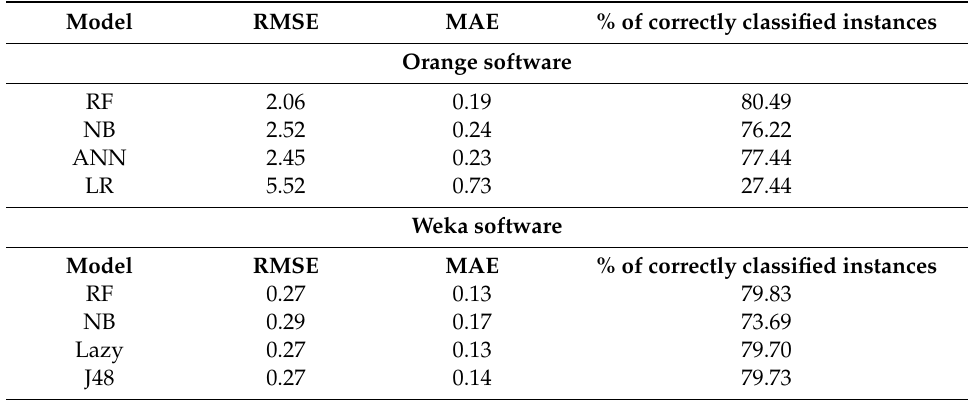
Table 2. Summary of evaluation metrics of all classification models’ performance in Orange and Weka.